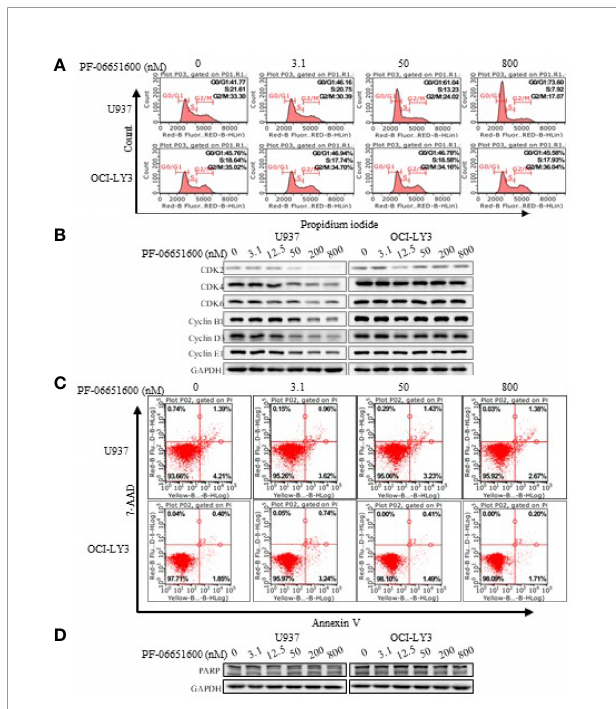
FIGURE 4 | Selective JAK3 inhibitor induced G0/G1 phase arrest in U937 cells. The change of cell cycle (A) and cycle-related proteins (B) was analyzed by fl ow cytometry and Western blotting 24 h after PF-06651600 treatment. Cell apoptosis (C) and apoptosis-related protein (D) were analyzed by fl ow cytometry and Western blotting 24 h after PF-06651600 treatment.